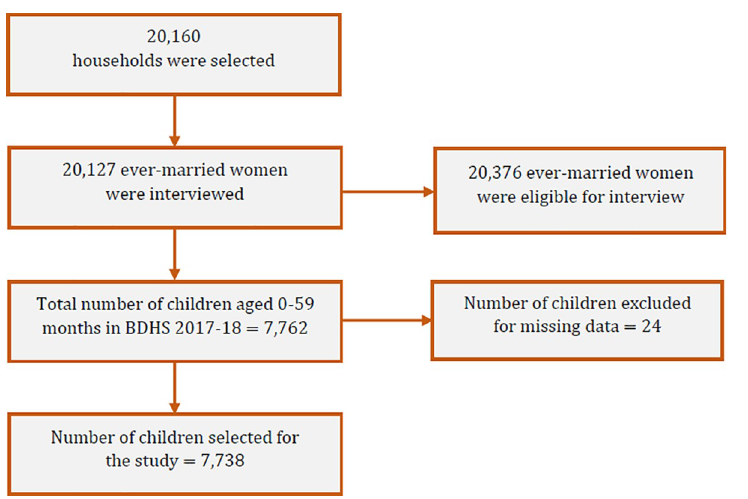
Fig 1. Sampling flowchart for the selection of